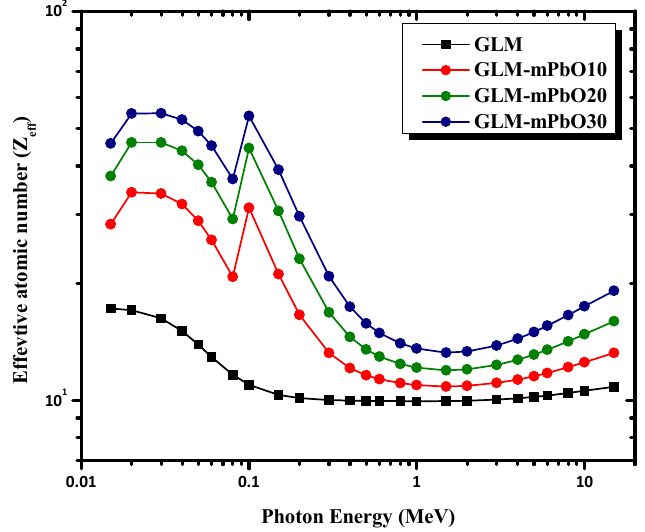
Figure 9. The Variation of the Z eff with incident gamma-ray energy of mortars.